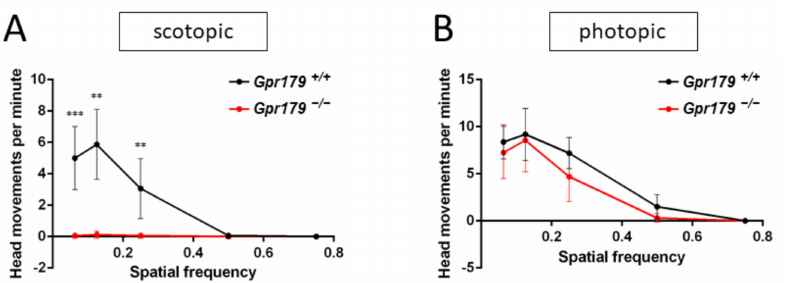
Figure 5. Optomotor responses. The number of head movements per minute was obtained in scotopic conditions ( A ) with spatial frequencies from 0.063 to 0.75 cycles per degree (cpd) and compared using the Kruskal–Wallis statistical test in representative Gpr179 +/+ (black line) and Gpr179 − / − (red line) littermates ( B ). Abbreviations: **: p < 0.005, ***: p < 0.0012.4. Localization of the Proteins of the